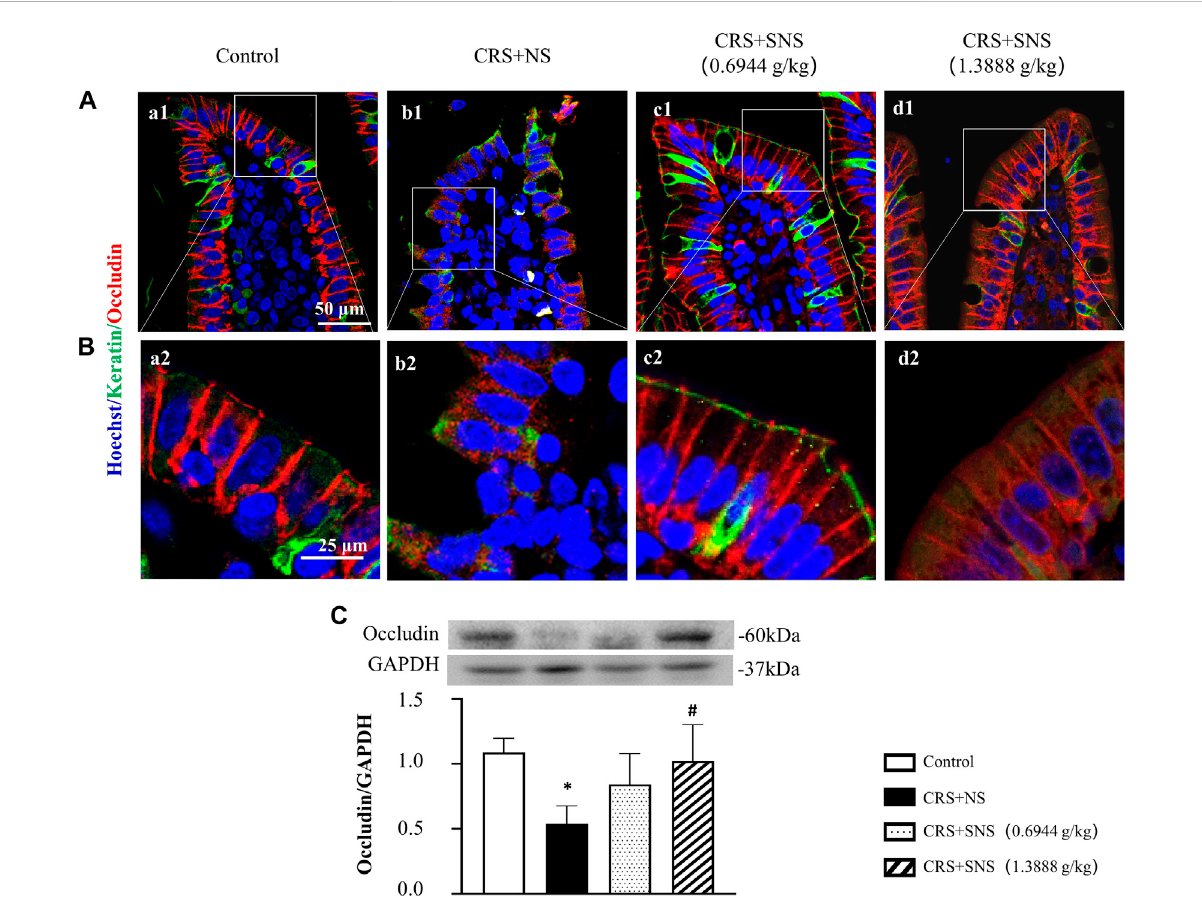
FIGURE 7 Effect of the SNS treatment on the occludin expression in the ileum epithelium. (A) Representative low magni fi cation of immuno fl uorescent staining images of ileum epithelium in Control (a1), CRS + NS (b1), CRS + SNS(0.6944 g/kg) (c1), CRS + SNS (1.3888 g/kg) (d1), respectively. The sections were immunochemically stained for Keratin (green), occludin (red), and nuclei (blue). Bar = 50 μ m. (B) Representative high magni fi cation of immuno fl uorescent staining images of the ileum epithelium in the Control (a2), CRS + NS (b2), CRS + SNS(0.6944 g/kg) (c2), CRS + SNS (1.3888 g/kg) (d2) groups, respectively. The sections were immunochemically stained for Keratin (green), Occludin (red), and nuclei (blue). Bar = 25 μ m. (C) Western blot of the occludin in the ileum of different groups with quanti fi cation showing below. F = 6.376. p = 0.0033. Results are presented as mean ± SEM. * p < 0.05 vs. Control group. (A,B) n = 3. (C) n =